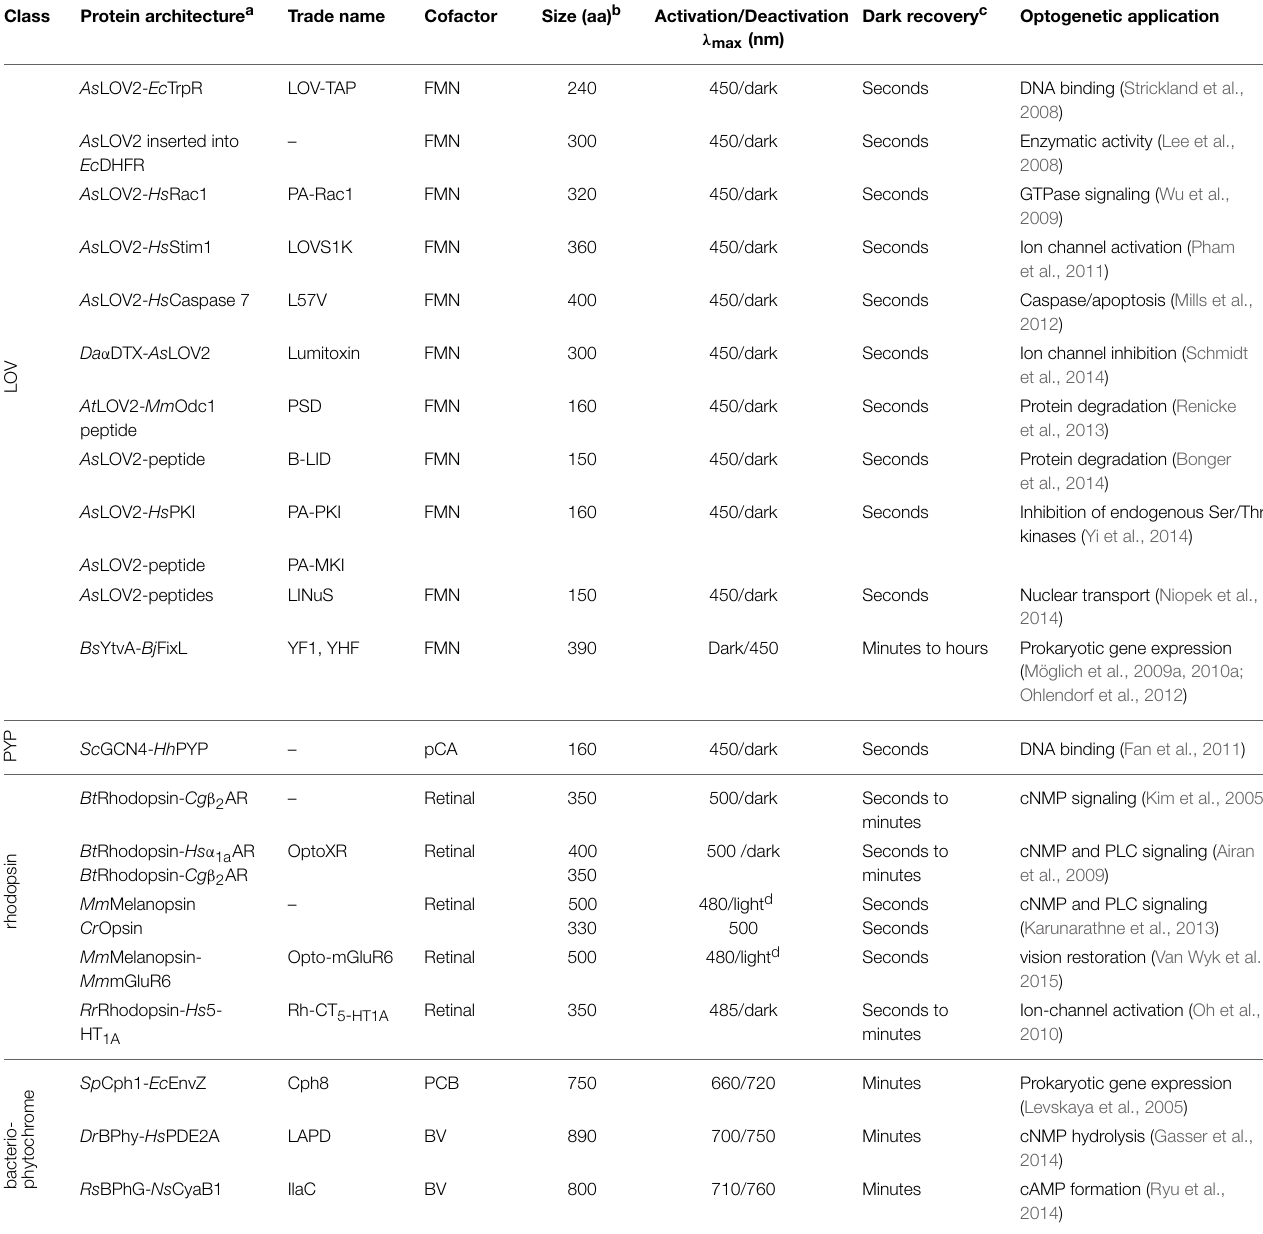
TABLE 1 | Non-associating engineered